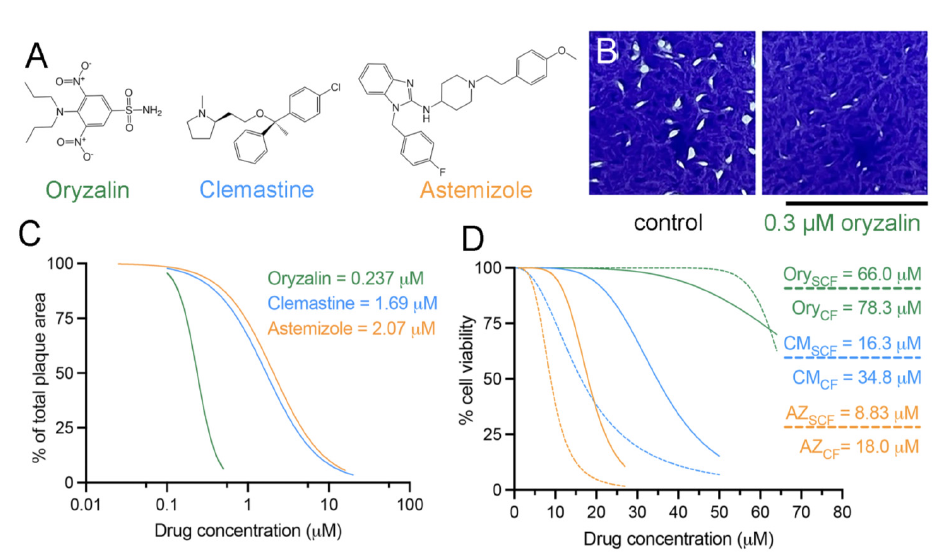
Figure 2. Efficacy and cytotoxicity establish the therapeutic index. ( A ) Chemical structures for oryzalin, clemastine, and astemizole. ( B ) After a week of undisturbed growth, lytic growth of RH strain tachyzoites creates visible holes in the HFF cell monolayer, as visualized after fixation, and crystal violet staining. Increased concentrations of compounds inhibit Toxoplasma replication and reduce the size and number of parasite-produced plaques. Control and 0.3 µ M oryzalin-treated wells are shown. Scale bar = 1.75 cm. ( C ) The relationship between plaque area and drug concentration is graphed to determine the 50% effective concentration. All values are normalized to null control cultures. The EC 50 values for clemastine (blue, CM), astemizole (orange, AZ), and oryzalin (green, Ory) showcase that all exhibit antiparasitic activity in the micromolar range. All results represent the average of at least 9 readings (3 biological replicates, each with 3 technical replicates) ± standard deviation. ( D ) The relationship between cytotoxicity (assessed by MTT assay-based quantification) and drug concentration is graphed to determine the CC 50 values for confluent (solid lines, CF) and subconfluent (dashed lines, SCF) cultures of human fibroblasts. All results represent the average of at least 9 readings (3 biological replicates, each with 3 technical replicates) ± standard